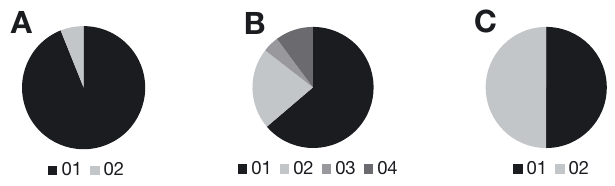
Fig. 6. Haplogroup distribution in (A) farmed seabass (n = 73), (B) wild seabass (n = 49) and (C) escapees (n = 22). Four haplogroups were identified from 3 single nucleotide poly- morphism (SNP) markers in the cytochrome b